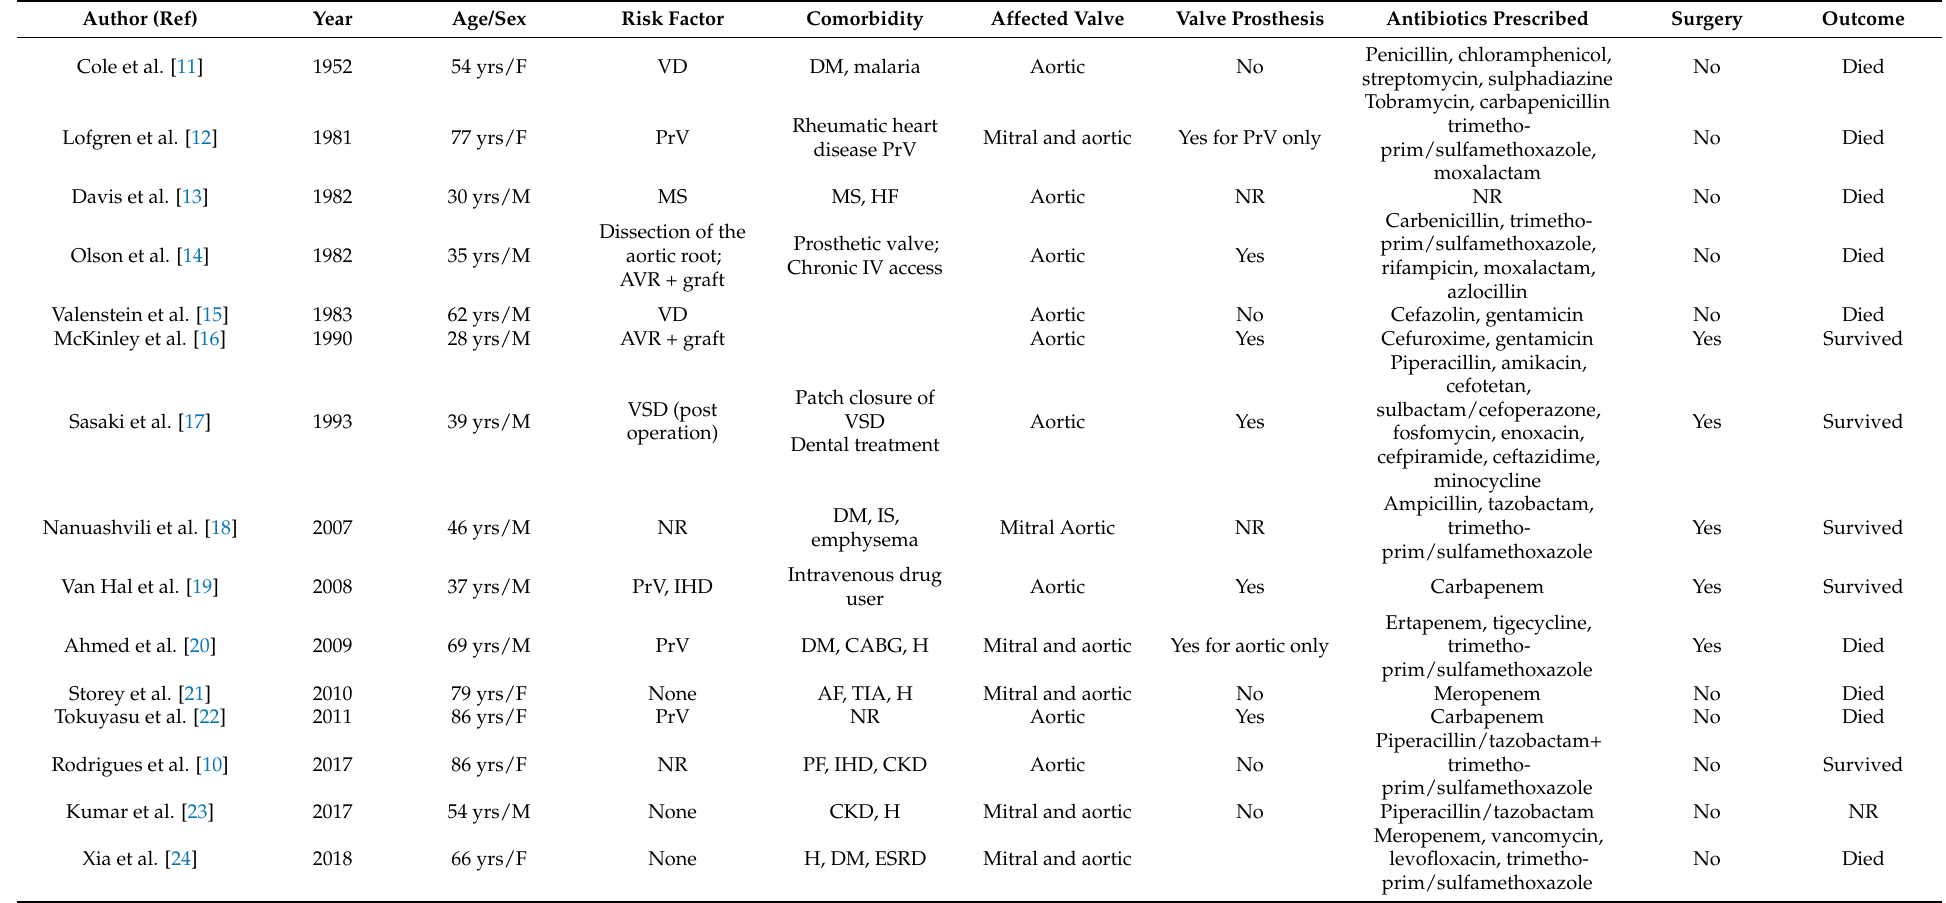
Table 2. Summary of previously reported Achromobacter spp. endocarditis involving aortic